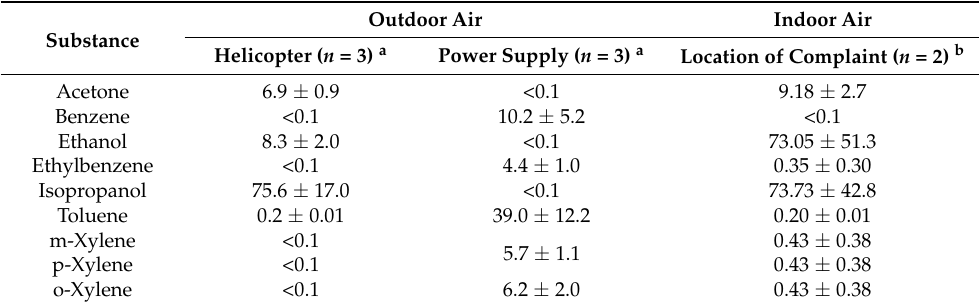
Table 5. Results of canister sampling at the source and time of an odor complaint compared to outdoor source locations.